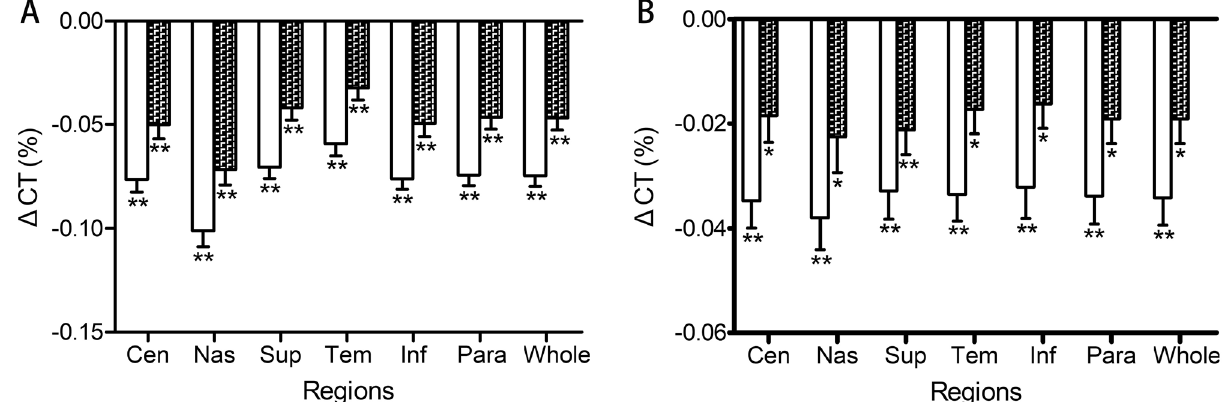
Figure 2. Changes in CT% at different locations immediately after exercise and after rest. ( A ) Changes of CT% at different locations of myopic eyes. ( B ) Changes of CT% at different locations of emmetropic eyes. The error bars represent the standard error of the mean (*, p < 0.05; **, p < 0.001 vs. pre-exercise, respectively). CT choroidal thickness; Cen central region; Nas nasal; Sup superior; Tem temporal; Inf inferior represents the mean data of inner and outer regions. Para, parafoveal region; Whole, whole region.